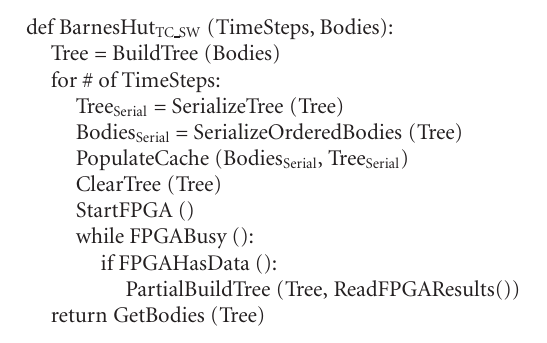
Algorithm 2: Pseudocode of the software portion of the (sim- ilarity-based) traversal cache implementation of